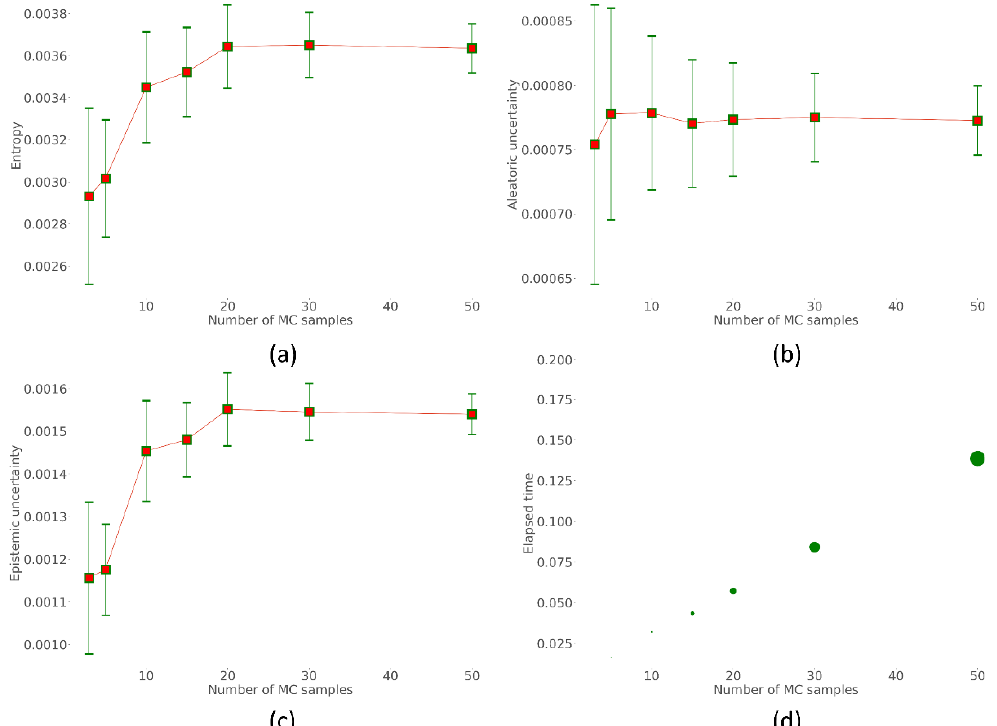
Figure 5. Identifying stabilizing points for various uncertainties based on the number of MC forward ( N ) passes. ( a ) Entropy; ( b ) aleatoric uncertainty; ( c ) epistemic uncertainty, and ( d ) elapsed time (in seconds).